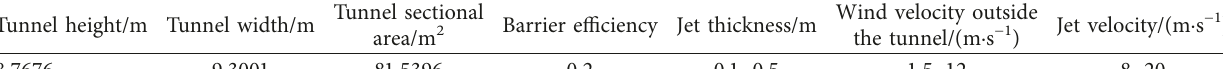
Table 1: Calculation parameters.